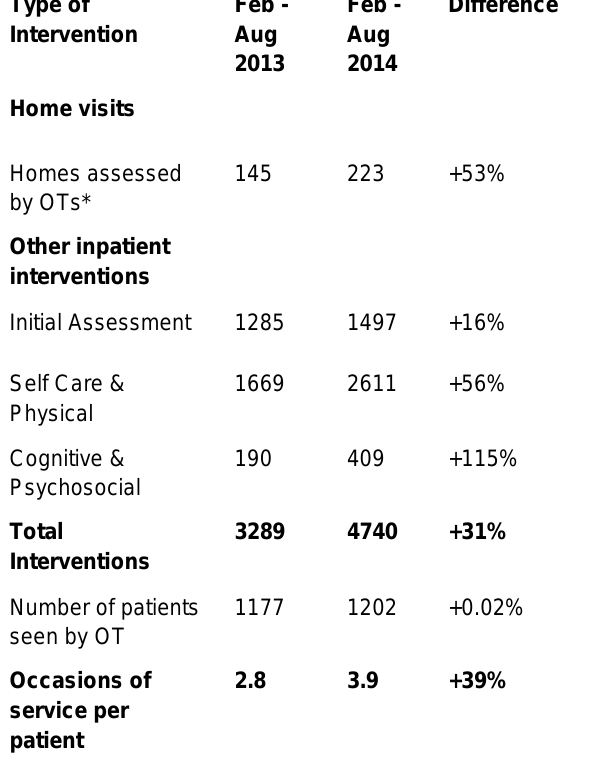
Table 3. Number of Occupational Therapy Interventions on Acute Inpatient Wards